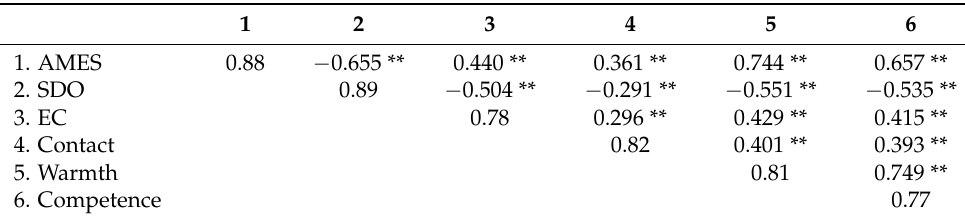
Table 3. Pearson’s correlations between AMES and other